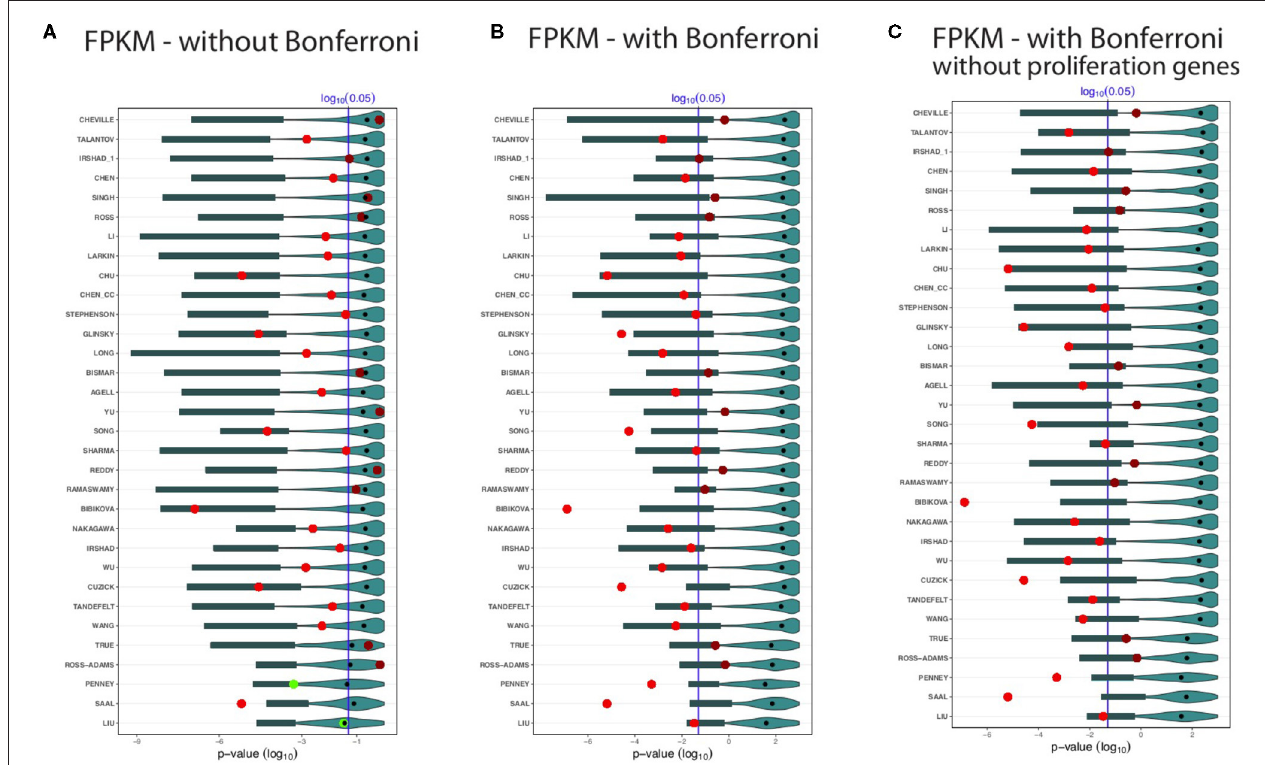
FIGURE 4 | Shown are the prognostic prediction results of random gene sets for 32 signatures using the GDC cohort B data set. (A) Results for uncorrected p -values. (B) Bonferroni corrected p -values. (C) Proliferation genes are removed and the p -values are Bonferroni corrected. The significance level is α = 0.05 (vertical blue line) and the light/dark red points represent the outcome of the published signatures. The blue colored distributions are the results of the random gene sets, whereas the shaded cyan bars correspond to the lower third percentile of the distributions and the bold black points are the median